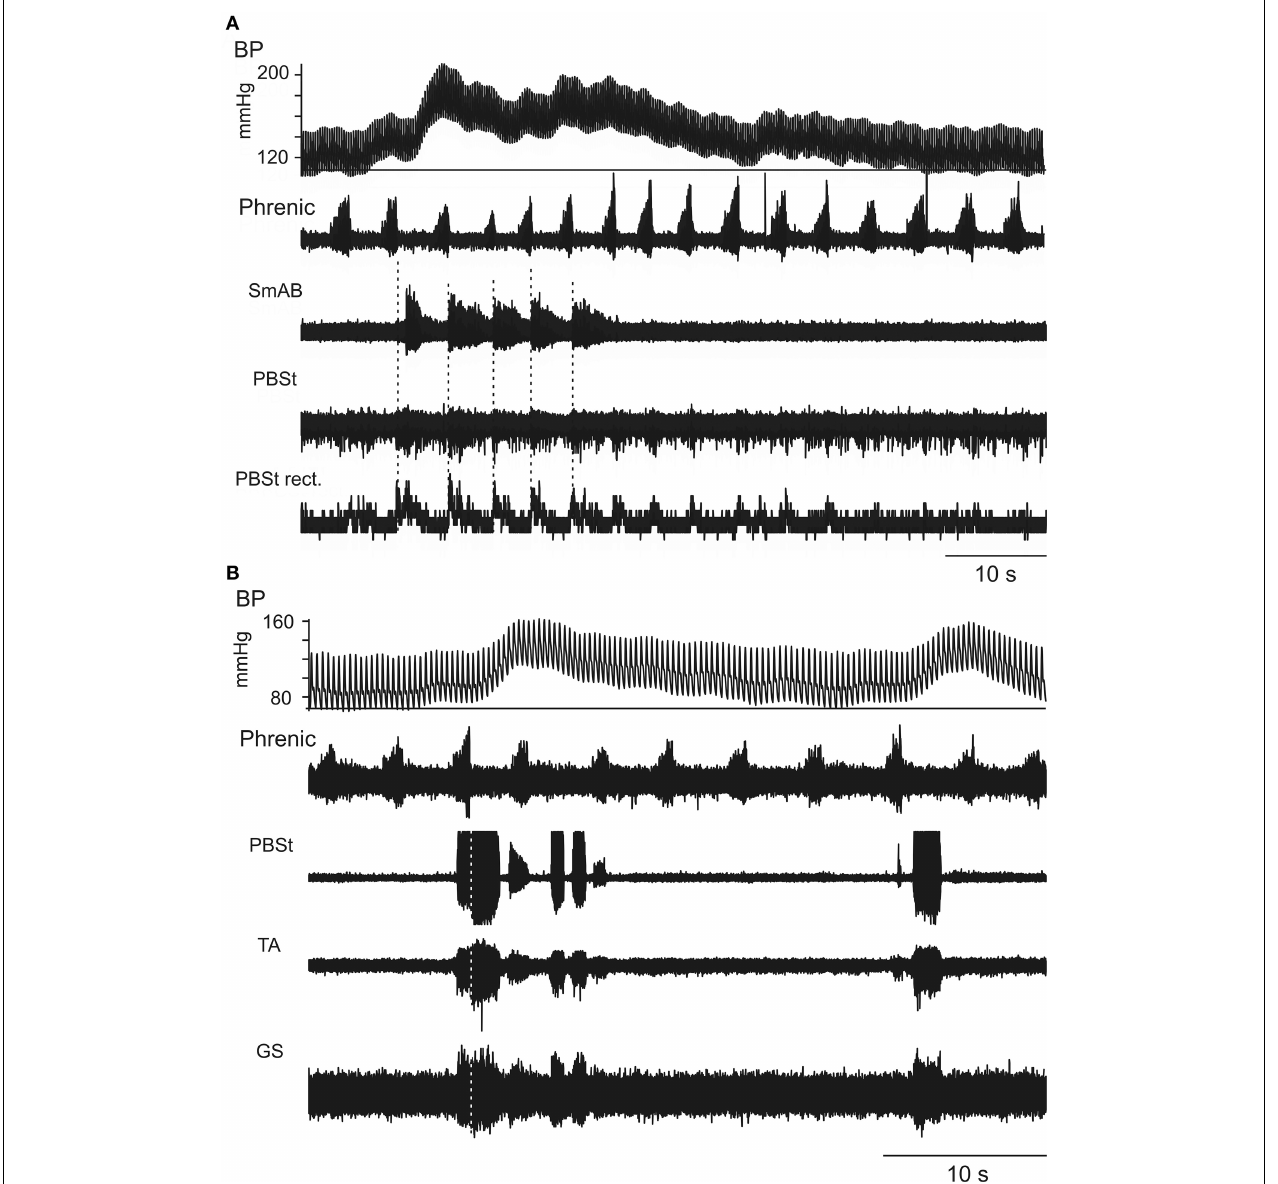
FIGURE 1 | Two different patterns of coupling between phrenic (inspiratory) discharges and hindlimb muscle nerve discharges. Appearance of one (A) or two (B) cycles of Mayer waves, as shown in the blood pressure (BP) traces and the phrenic nerve recordings (second traces). As was common, the phrenic nerve discharges in the respiratory cycle or cycles at or just before the hypertensive phase were more intense than in average respiratory cycles and the discharges during the hypertensive phase were less intense. In (A) the initial increase prior to the Mayer wave is difficult to judge as it occurred at the very beginning of the recording, but the less intense discharges during the blood pressure increase are easily seen. The following three traces show (A) the raw ENGs from SmAB and PBSt,